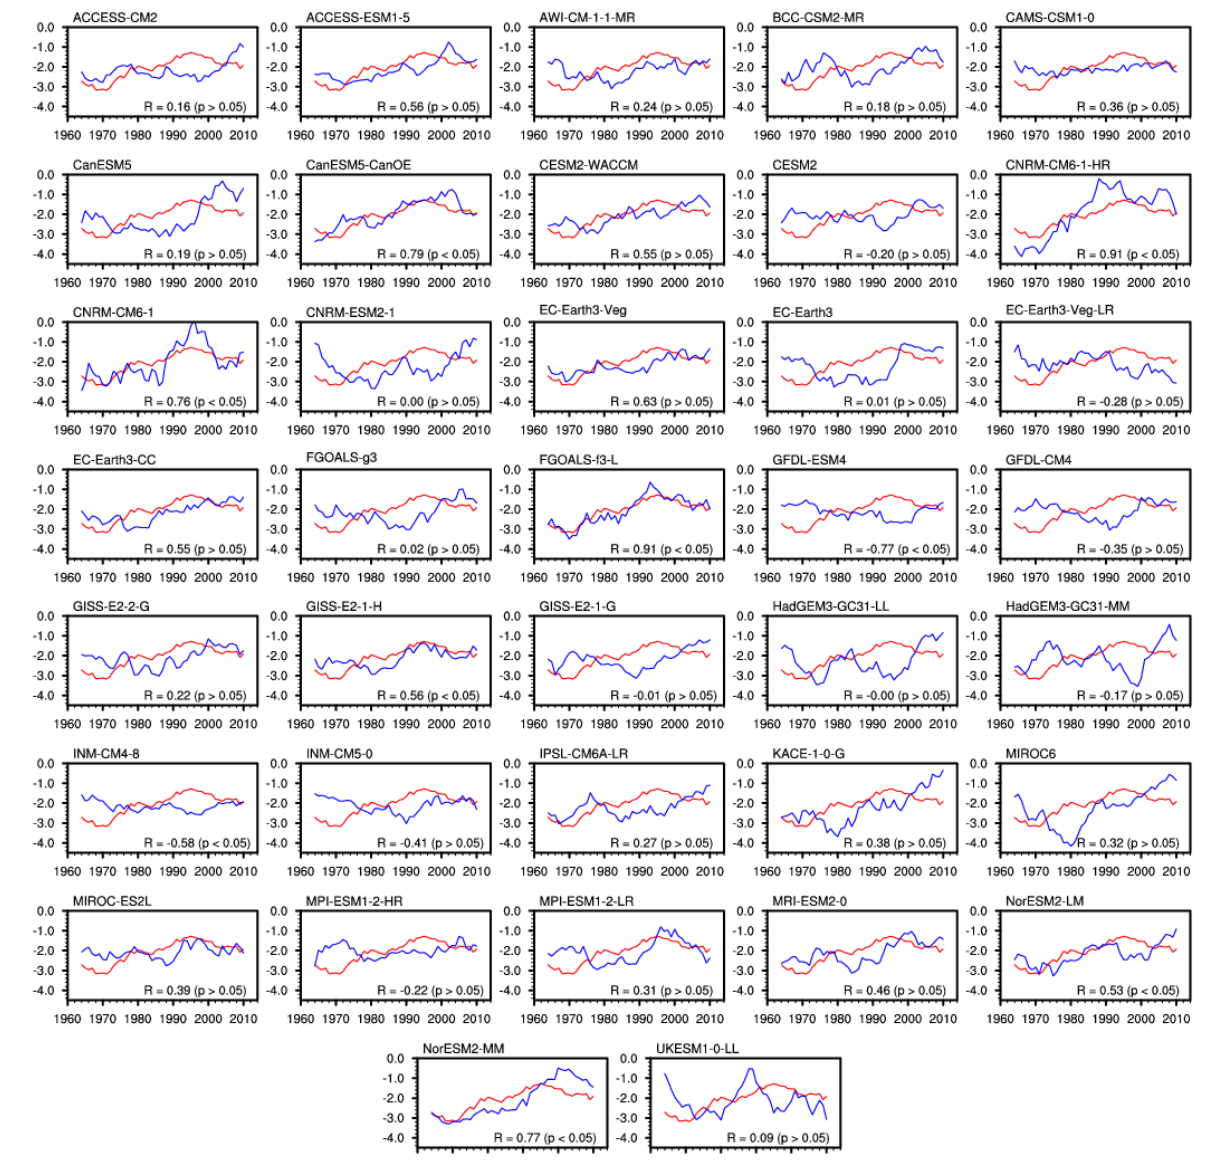
Figure 3. Nine year smoothed time series of the winter mean temperature (unit: °C) derived from the historical simulations (blue line) for the individual models during 1960–2014 in Beijing. The x -axis refers to the year, while the y -axis refers to the temperature. The red line denotes the observation, and R is the correlation between the observation and simulation.